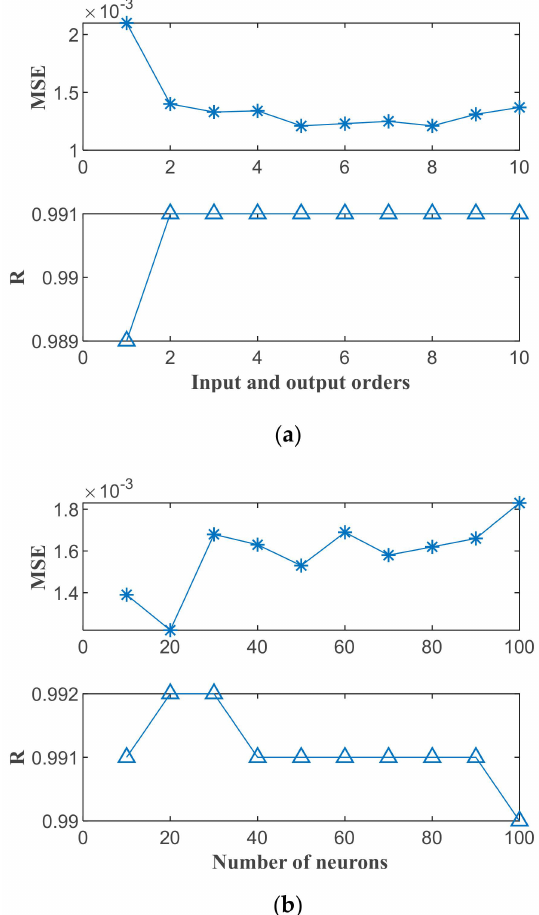
Figure 10. Performance indices of brake intensity recognition using the close-loop NARX network with di ff erent memory orders and numbers of neurons. ( a ) Performance with di ff erent memory orders; ( b ) Performance with di ff erent numbers of